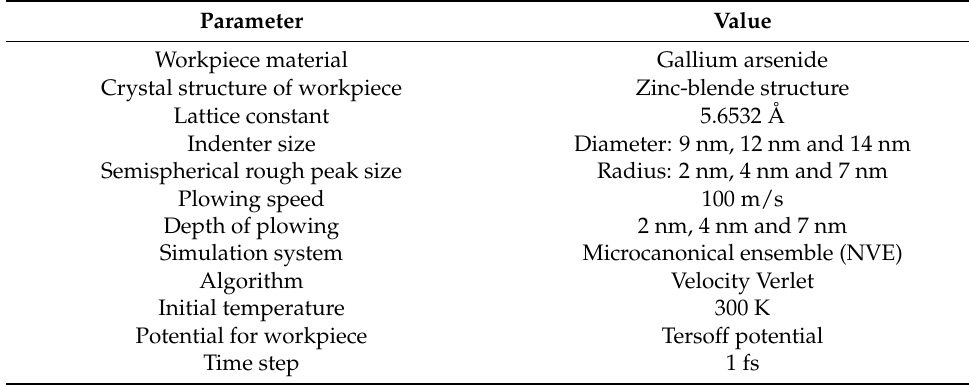
Figure 1. Schematic of the plowing model with a spherical asperity on GaAs substrate. Table 1. Detailed parameter settings in the MD simulation